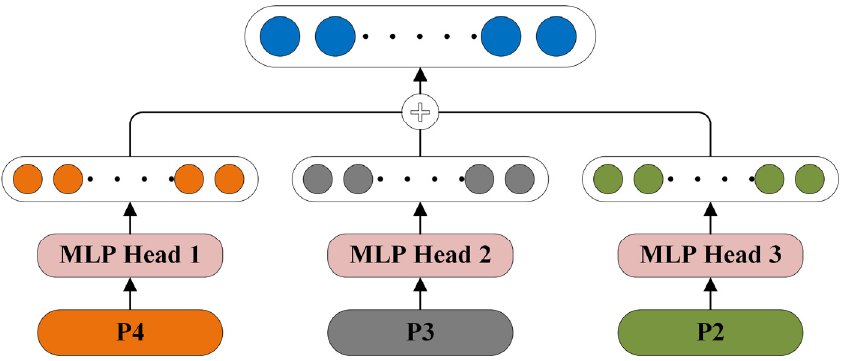
Figure 4. Classification header structure.